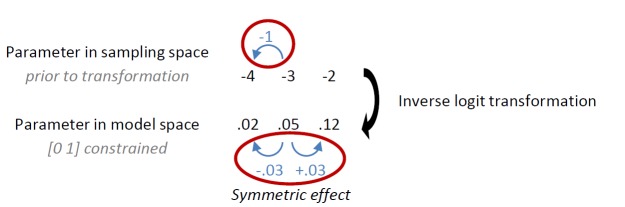
DOI:
http://dx.doi.org/10.7554/eLife.22169.029